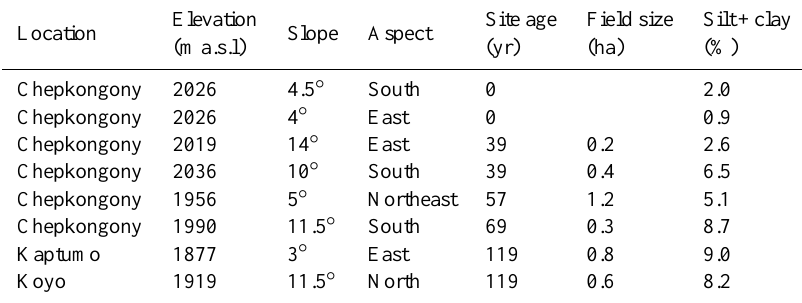
Table 1. Sample site information.